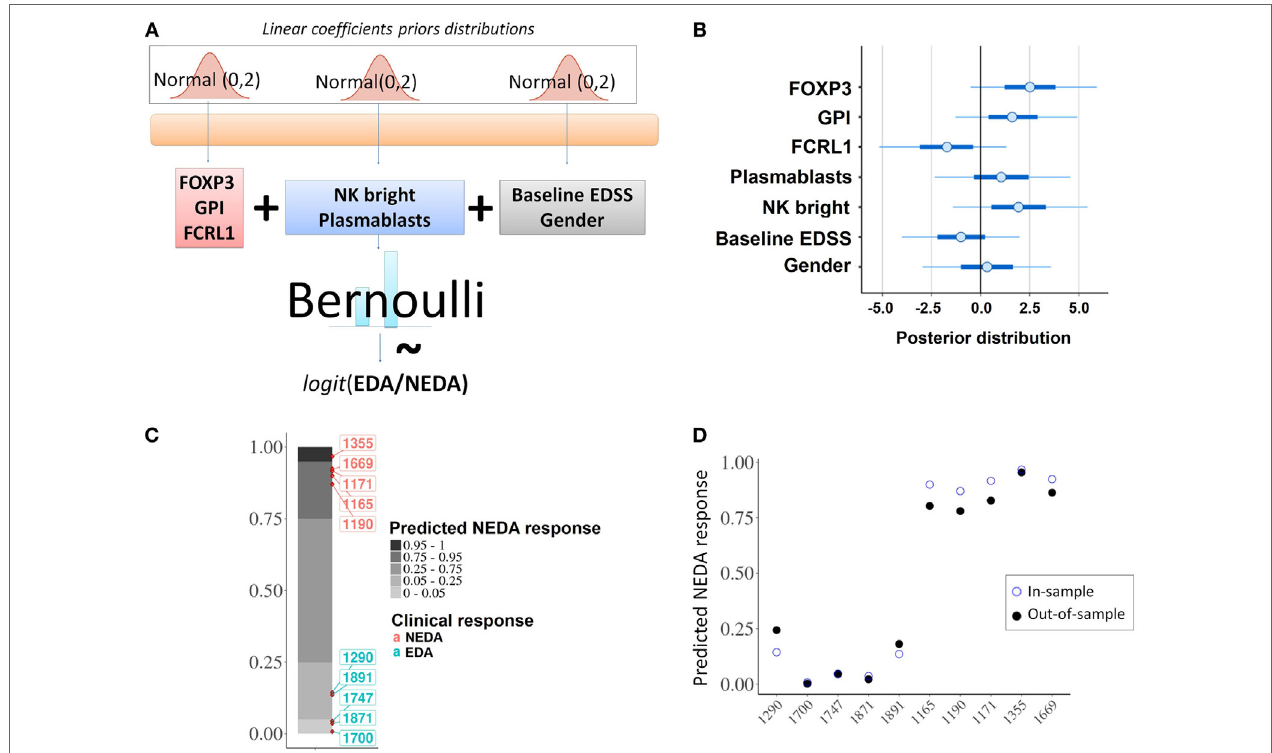
FigUre 7 | Predictive model. (a) Schematic representation of the probabilistic linear model for the fingolimod response. (B) Individual contributions of each of the selected predictors; the graph shows the posterior distribution of the estimated coefficient for the linear model, indicating the mean (dots), 50% quantile (thick line) and 95% quantile (thin line). (c) In-sample posterior predictive check; the model was correctly fitted to the given data predicting the expected response for the 10 considered patients. (D) In-sample vs out-of-sample prediction comparison; out-of-sample predictions using an approximation of leave-one-out cross-validation (filled dots) were compared with in-sample predictions (empty dots).